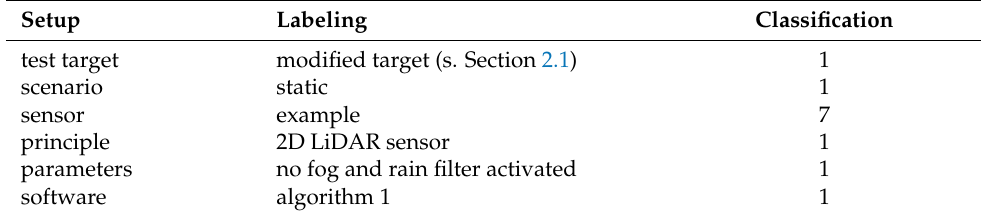
Table 2. Setup table for the test example with a 2D LiDAR sensor.